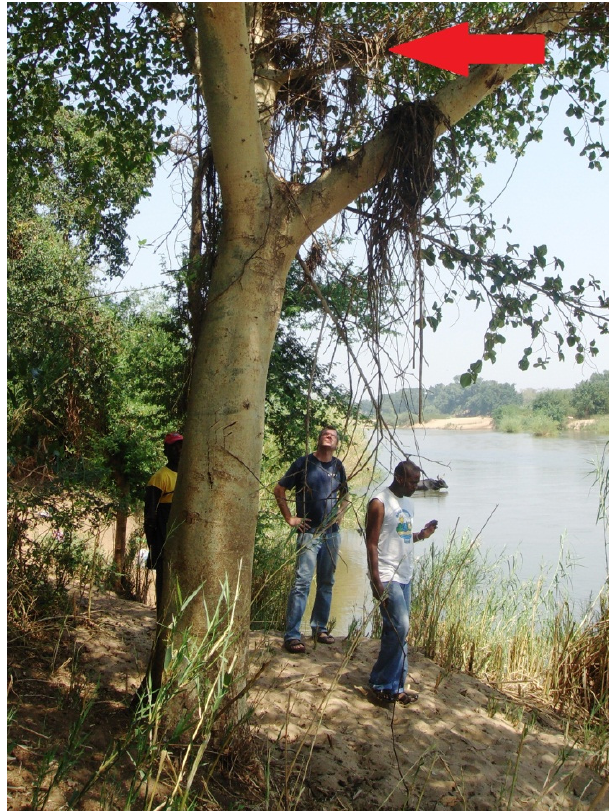
Figure 14. High water mark at the Olifants–Limpopo confluence (photographer: De Dapper,